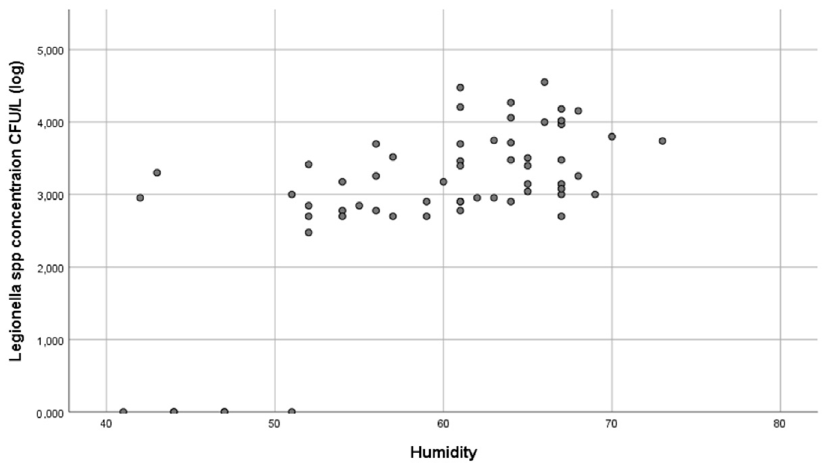
Figure A1. Legionella spp. concentration (on a logarithmic scale) correlated with humidity.